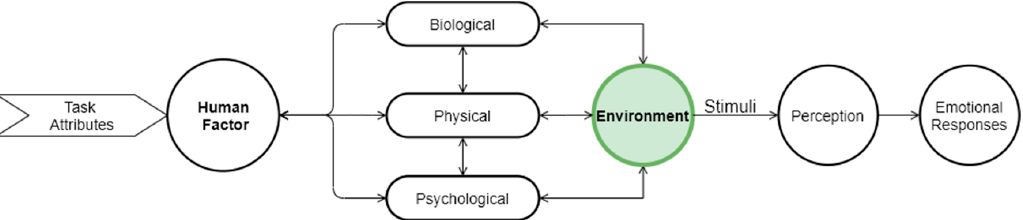
Figure 4. Built environment and human responses [15,17,24,49,60].